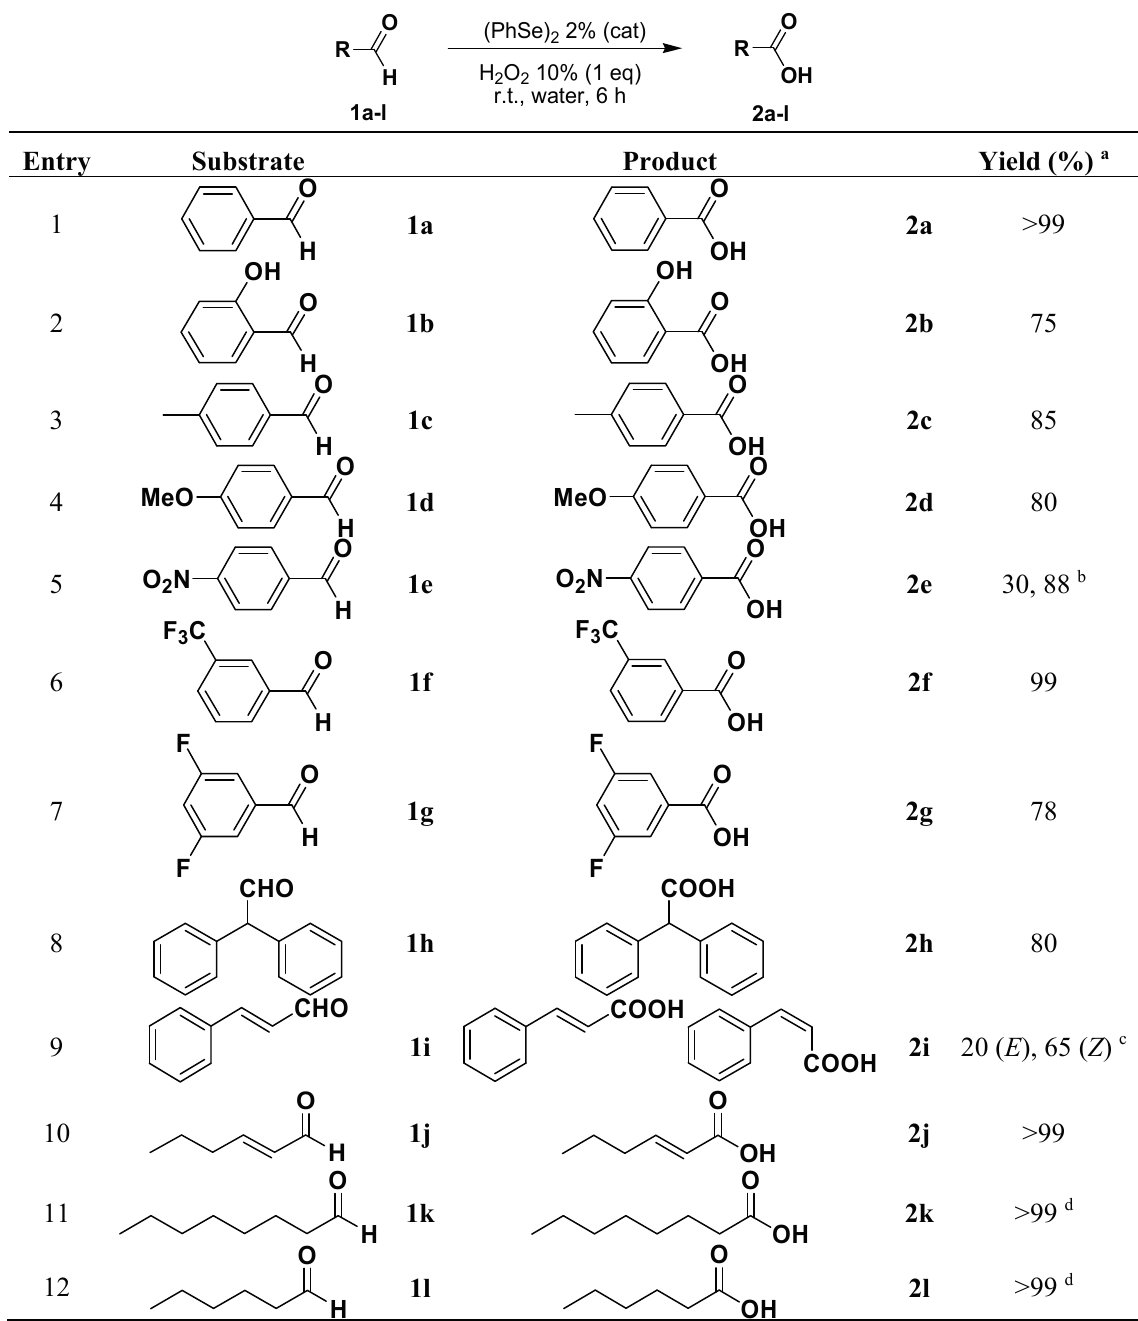
Table 2. Oxidation of aldehydes to carboxylic